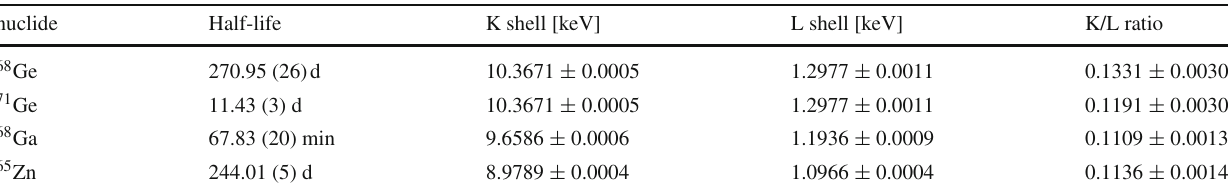
Table 7 Literature values of cosmogenic induced X-ray energies and half-lives of Ge-related radioisotopes that are used for the calibration of the Conus detectors. K and L shell values are taken from Ref. [67]